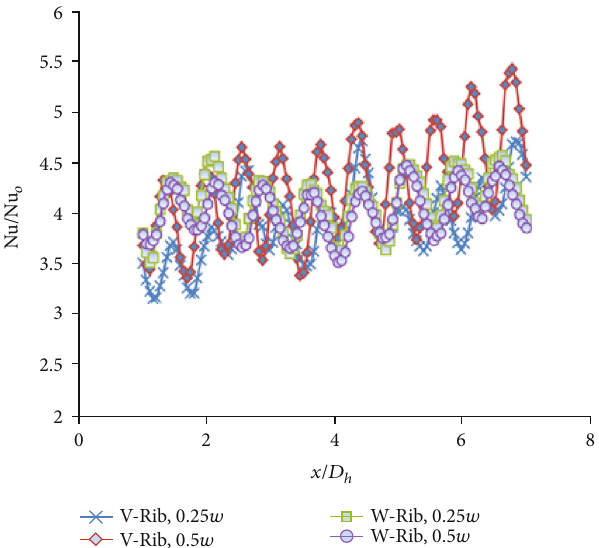
Figure 5: Streamwise variation of Nu/Nu